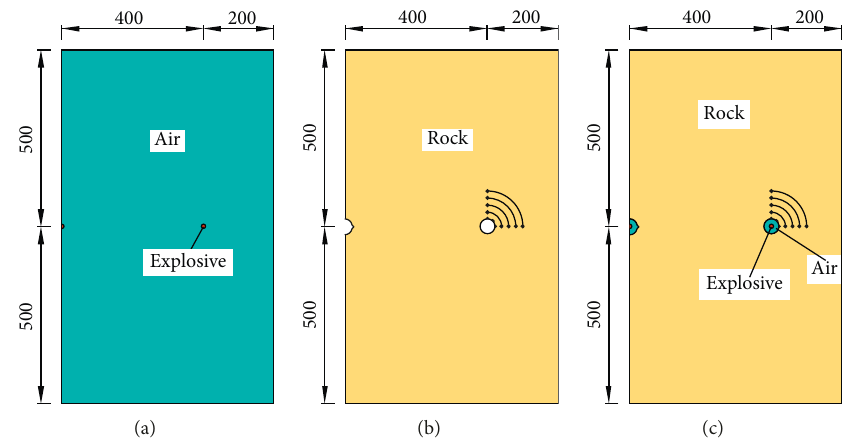
Figure 4: Successive blasting holes spacing is constant. (a) Air and explosive model. (b) Rock model. (c) Complete models of air, explosive, and rock.